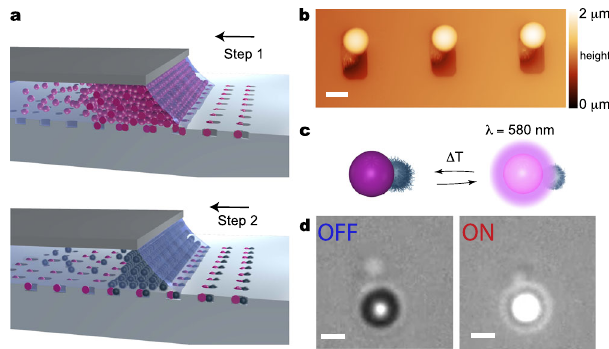
Fig. 1 Fabrication of thermo-responsive recon fi gurable dumbbells. a Scheme of the deposition of polystyrene (PS) particles (step 1) and PNIPAM-co-MAA microgels (step 2) onto a PDMS template patterned with 2 × 4 μ m 2 size traps. The arrow indicates the direction of the deposition. Particles are accumulated at the meniscus of the moving droplet and deposited into the traps via capillary forces. b AFM image in the water showing PS-microgel dumbbells in the traps before harvesting. The bright spheres are the PS colloids and the darker ones are the swollen microgels. c , d Schematic representation c and optical micrographs d of the light- driven recon fi guration of a dumbbell. Fluorescent illumination with a power density ρ FL = 54 mW(mm) − 2 locally increases the temperature above the VPTT of the microgel, causing it to deswell and correspondingly induce a variation of the dumbbell ’ s geometry and dielectric properties. The transition is reversible upon removing the incident light. Scale bars: 2 μ